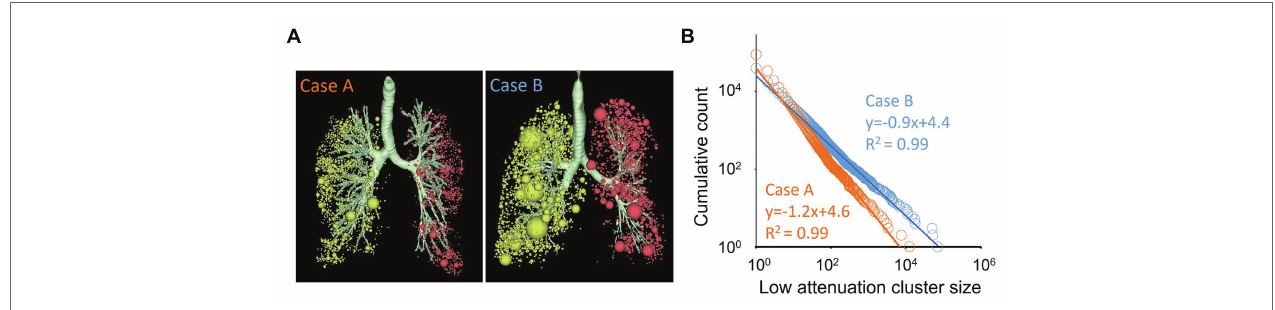
FIGURE 3 | The power-law exponent D for the size distribution of emphysematous clusters on CT. (A) 3D visualization of low attenuation clusters (LACs) for two cases. Each sphere indicates a LAC that was identified as neighboring voxels in 3D on CT. Of note, many small clusters were found in case A, whereas several larger clusters and many small clusters were found in case B. (B) Cumulative count of LACs larger than a given size was plotted on a double logarithmic scale, and the power-law exponent D was calculated as the negative slope of the regression lines. The exponent D for cases A and B were 1.2 and 0.9,